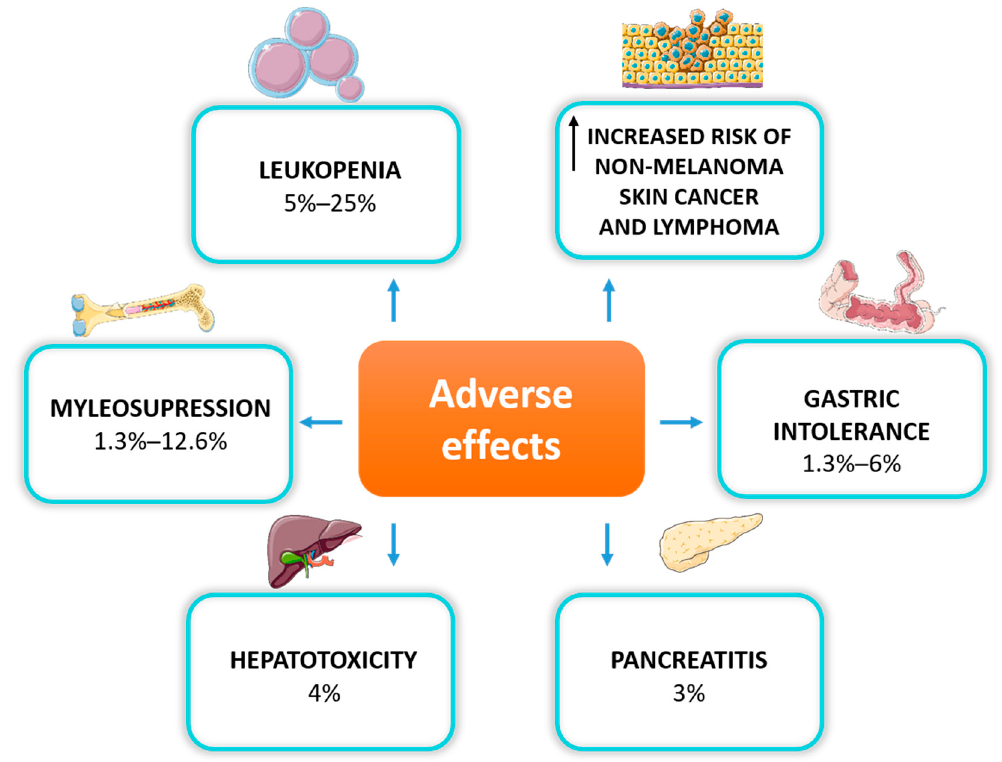
Figure 2. Adverse effects of thiopurine therapy in IBD patients.